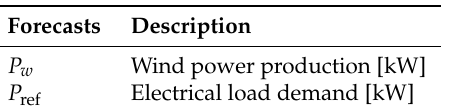
Table 2. Forecast powers.